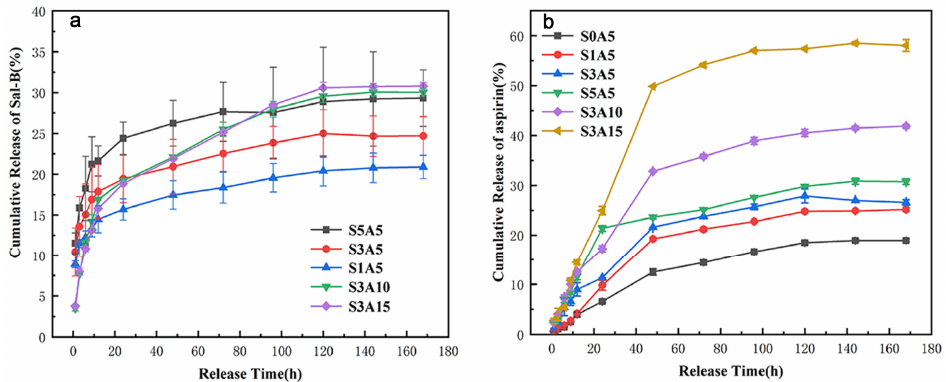
Figure 12. Cumulative release of dual drug-loaded biomimetic nanofibrous scaffolds: Sal-B ( a ) and ASA ( b ).